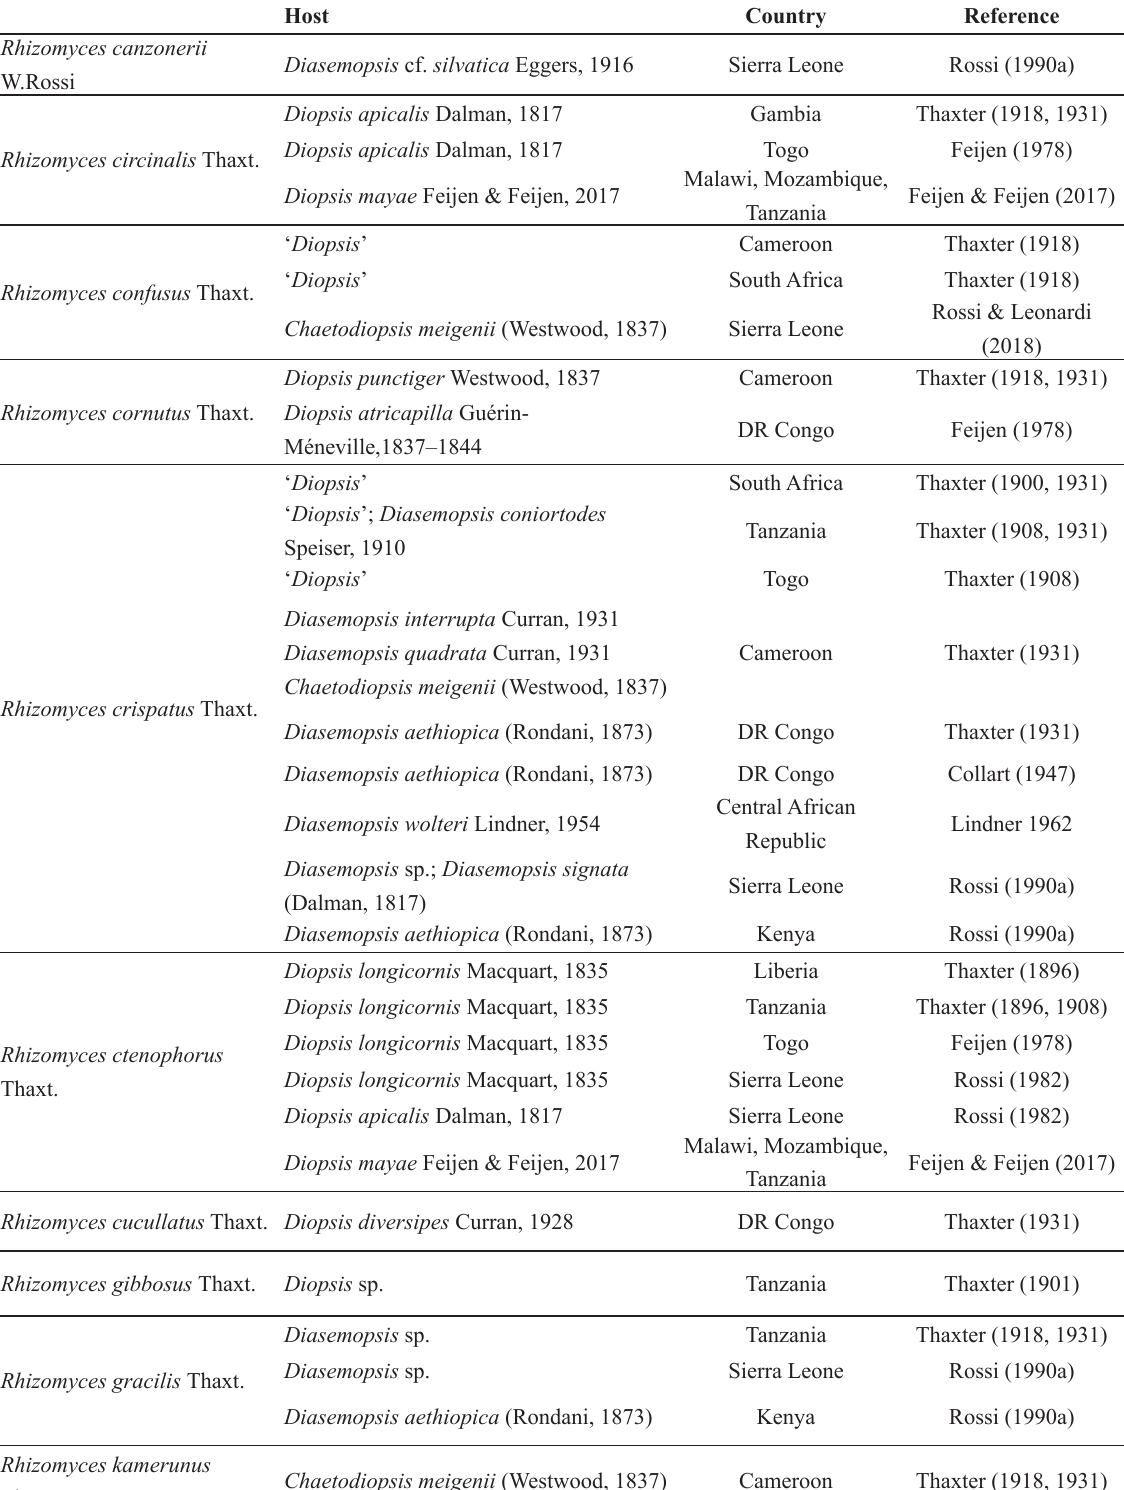
Table 1 . Literature records for the Rhizomyces Thaxt. species, indicating host and country. If necessary, host names have been updated to bring them in line with actual views on the taxonomy of Diopsidae. Records of unidentified species (such as Rhizomyces sp.) and confusing records were not